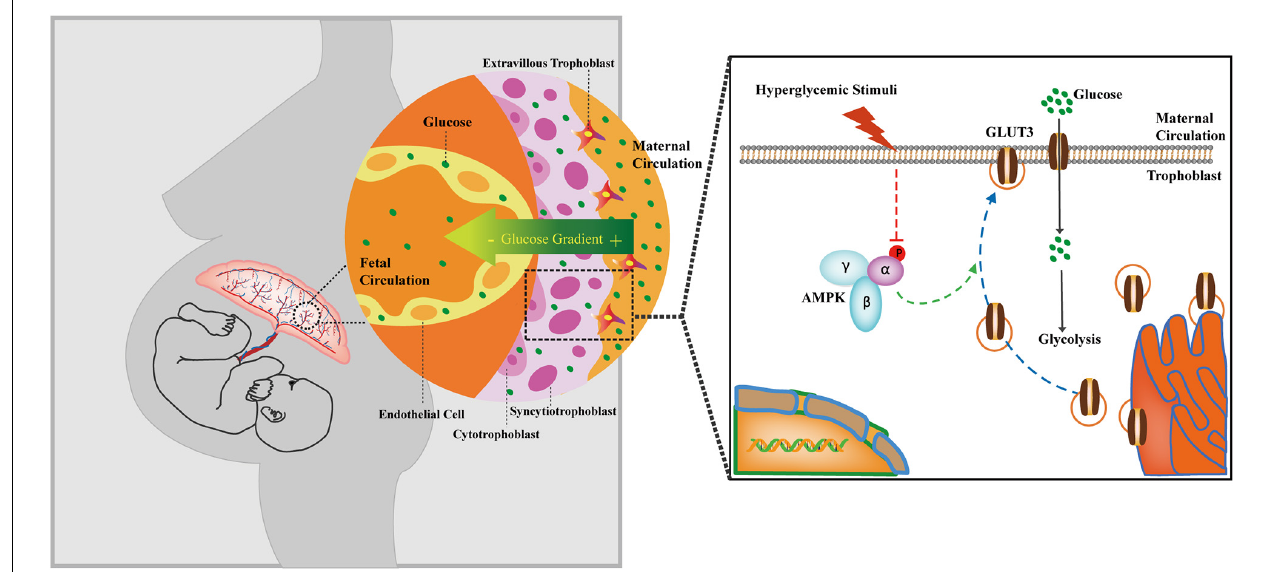
FIGURE 7 | Cartoon representation showing the proposed working model of the trophoblastic AMPK-GLUT3 axis in response to maternal hyperglycemia.